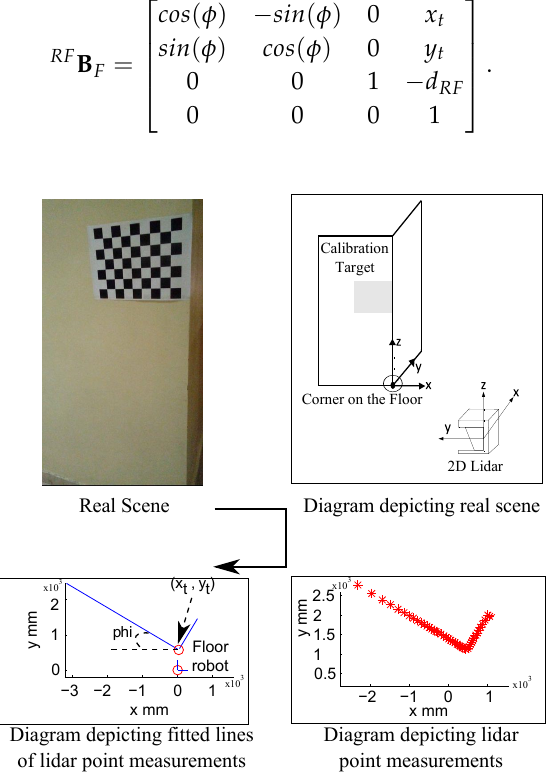
Diagram depicting lidar point